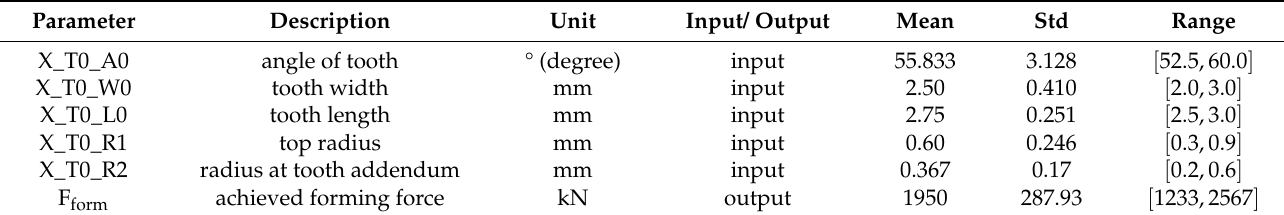
Table 3. Input and output parameters for the FEA parameter study.